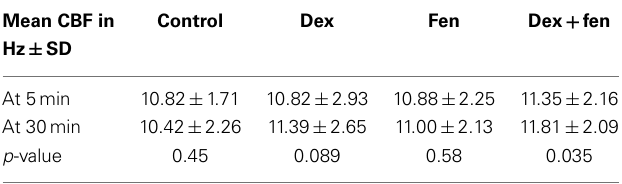
Table 2 | Multivariate regression model at 37°C